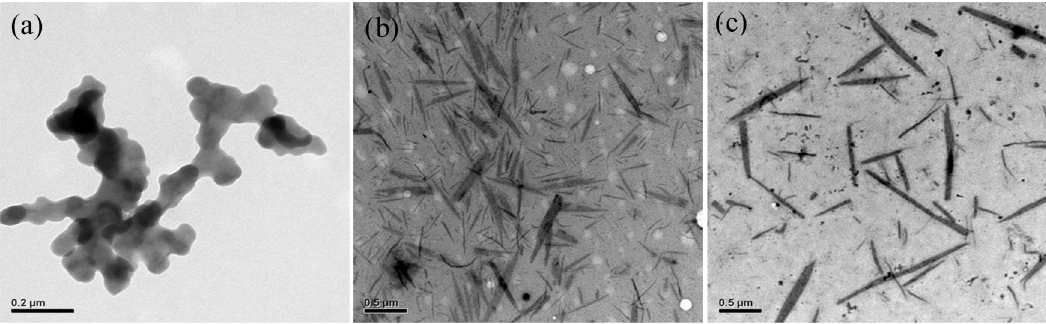
Figure 10. TEM images of POF 10 – b– PDPAEMA 197 aggregates in water at different pH levels: ( a ) 2, ( b ) 7, ( c ) 11.